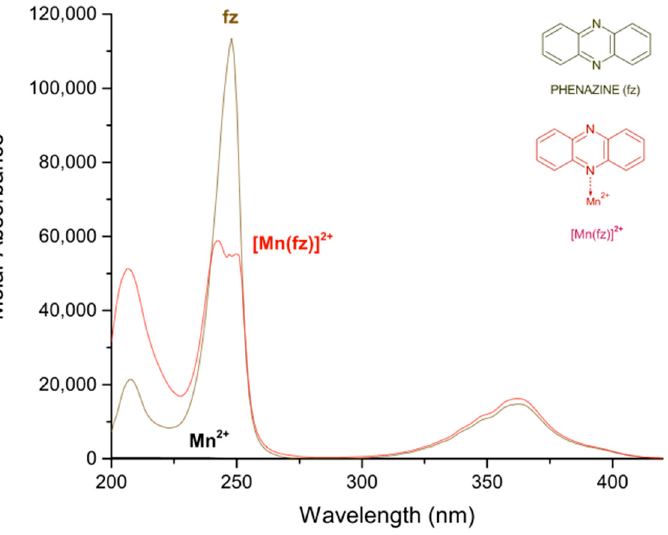
Figure 3. Calculated electronic spectrum of manganese(II)–phenazine in methanol: phenazine (fz), Mn 2+ and [Mn(fz)] 2+